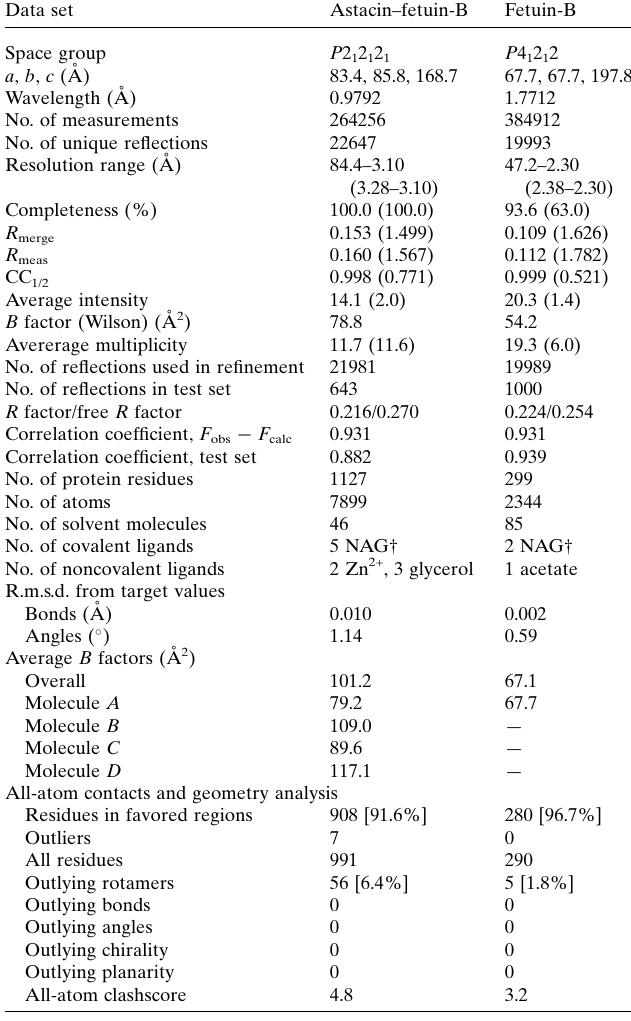
Table 1 Crystallographic data. Values in parentheses are for the outermost resolution shell. Data set